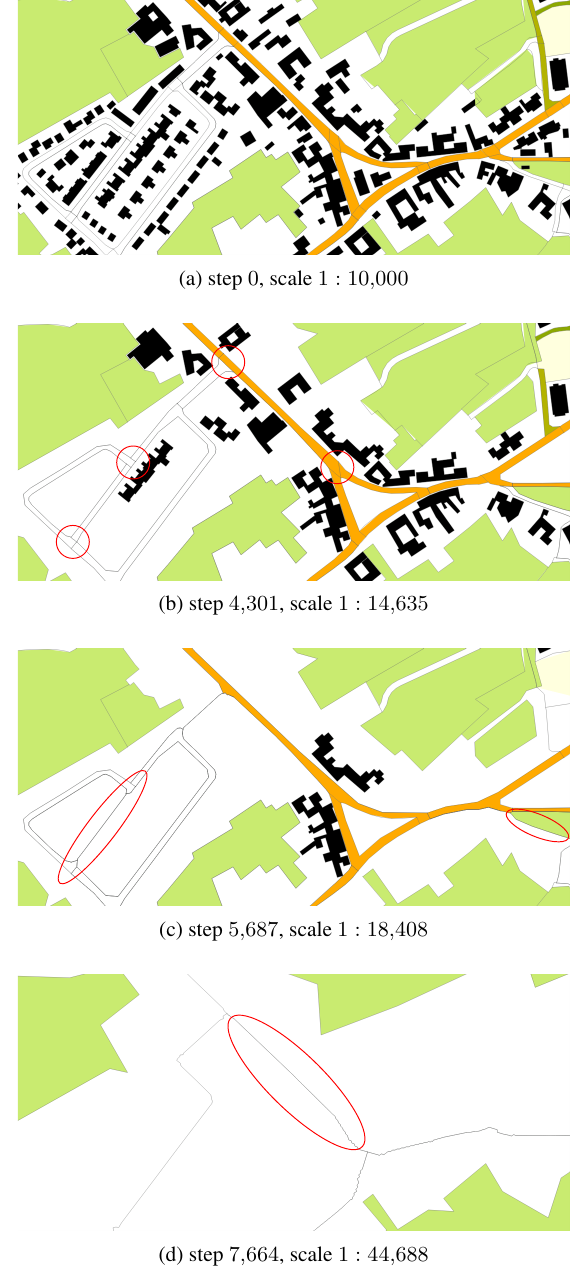
Figure 6. Initial results. Merging and splitting of road objects follows the generalization actions, dependent on the estimated scale, specified in Table